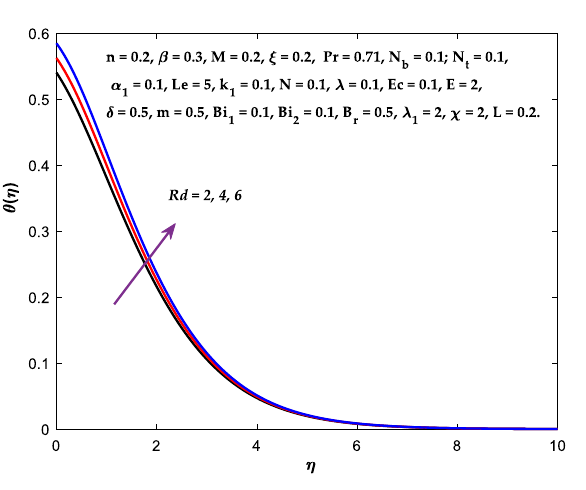
Figure 9. Diagram of R d v/s θ(η) .